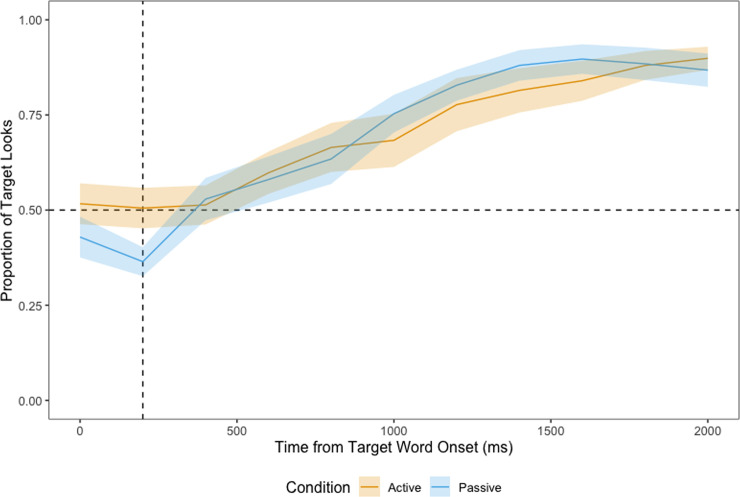
Proportion of looks at the target in familiar trials, time-locked to the onset of the target word.Dashed vertical line at 200 ms marks the beginning of the analysis window, dashed horizontal line represents chance (0.5).